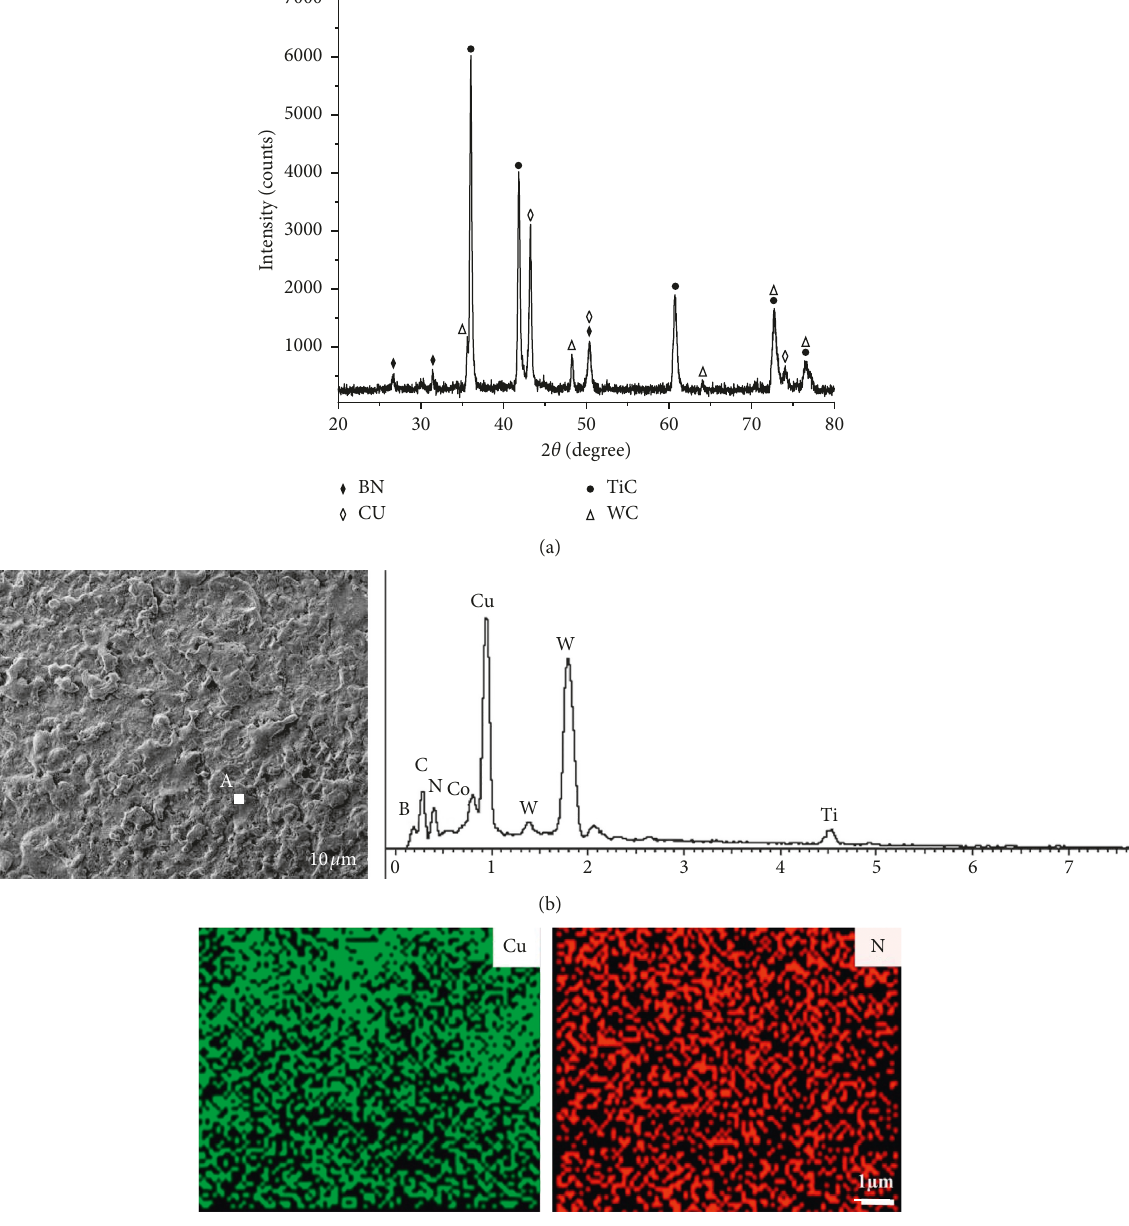
Figure 3: (a) X-ray diffraction patterns; (b) SEM image and EDS spectrum of the Cu/h-BN coating; (c) N and Cu elements distribution corresponding to area A of